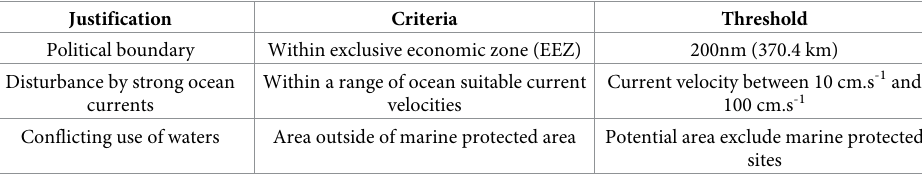
Table 1. Selected criteria for defining the potential area for mariculture